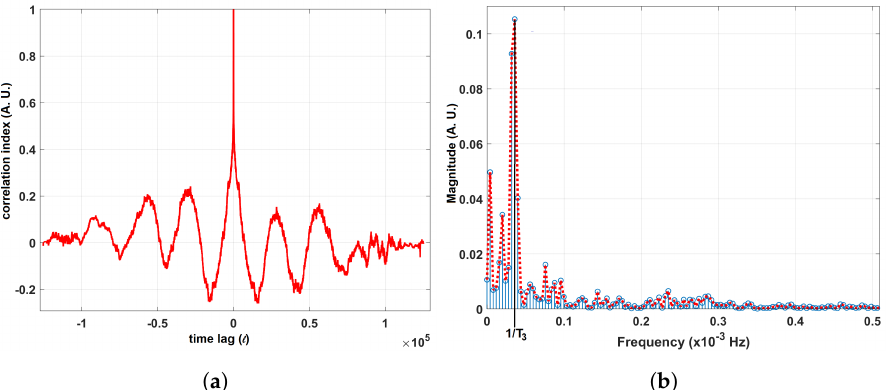
Figure 12. ( a ) Correlogram computed from data collected with sensor S-5 during October 18th and October 19th. ( b ) The corresponding frequency